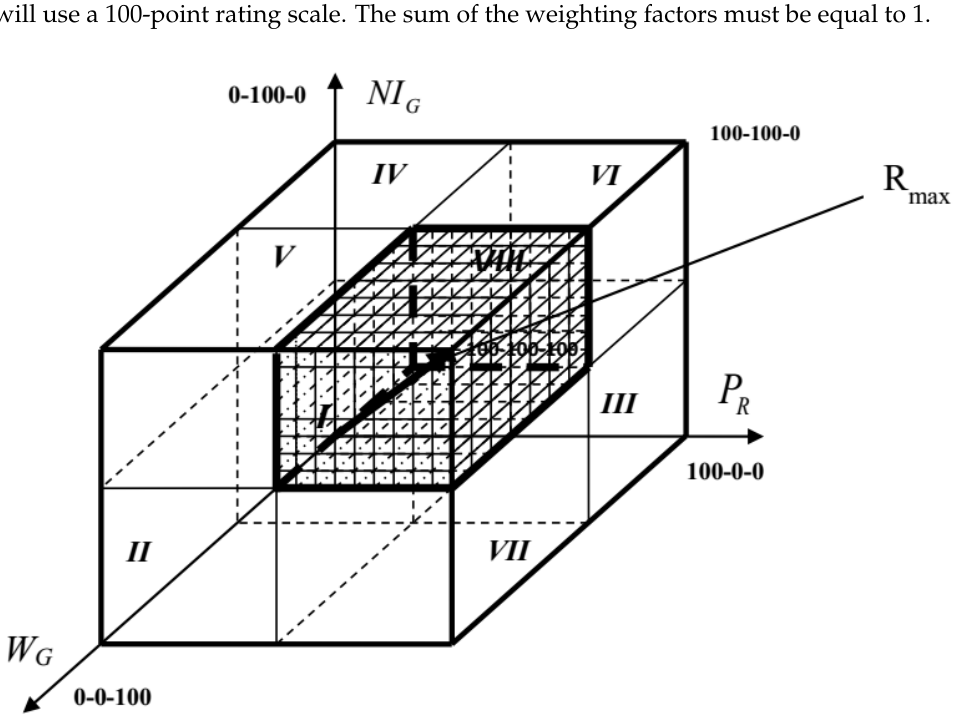
Figure 3. Graphical interpretation of a three-criteria spatial model for assessing the risk of an enterprise in a cluster developed by Izmalkova I. and Vertakova Yu.